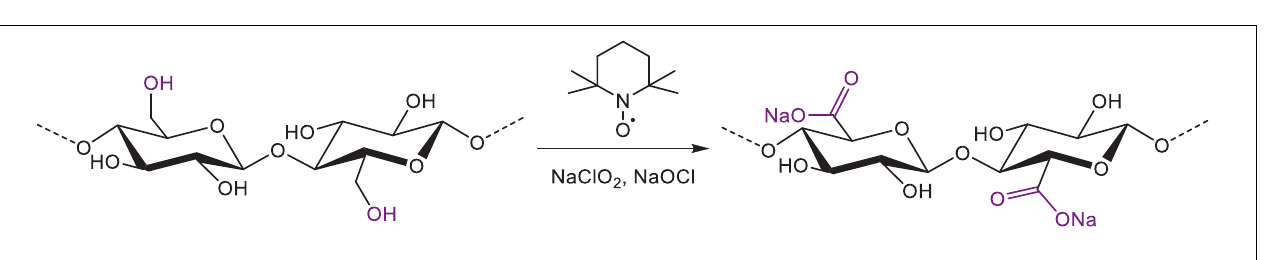
FIGURE 3 | Oxidation of β -glucan in the presence of nitroxyl radical (TEMPO) and bleach to form a β -polyglucuronan.